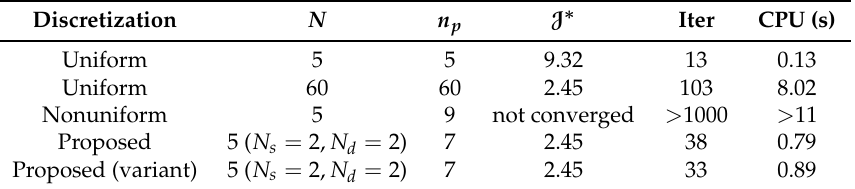
Table 1. Optimal objective values, number of iterations, and CPU times for different discretization strategies in Problem (37). n p denotes the total number of optimization variables for each strategy.